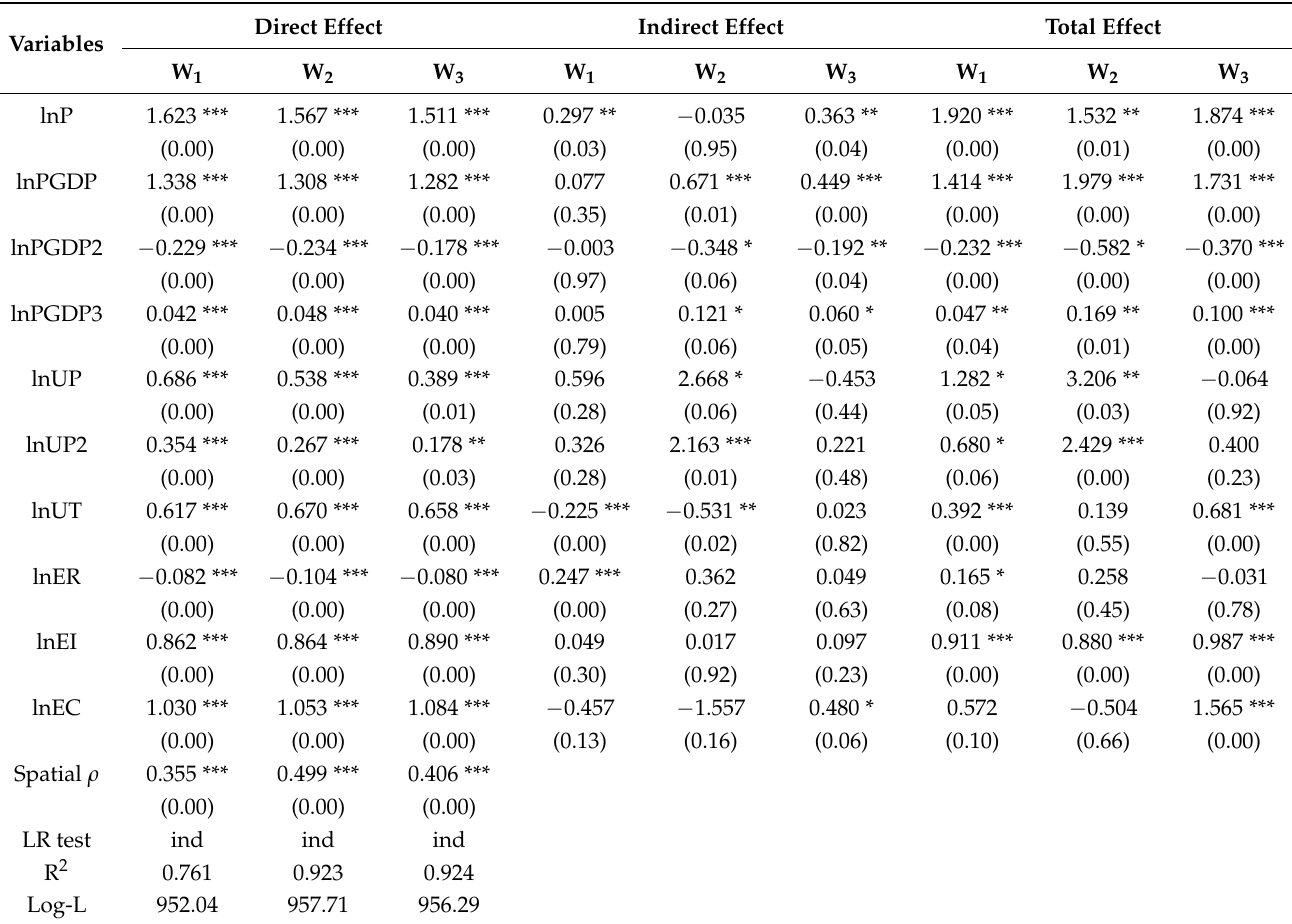
Table 7. Spatial panel regression results of the operation